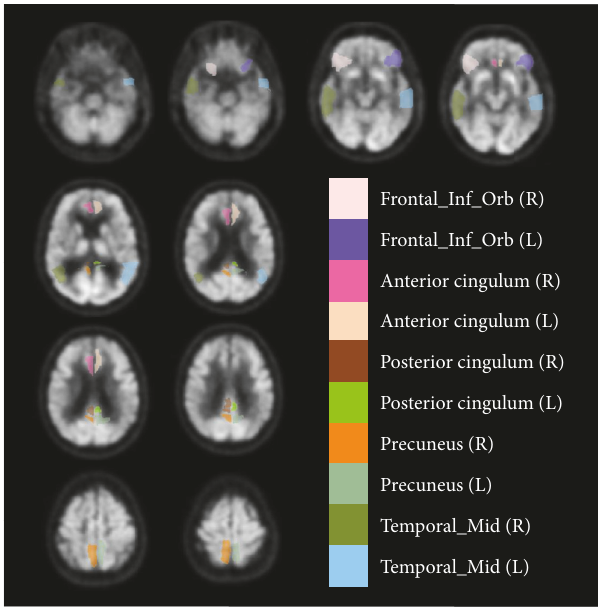
Figure 3: Selected regions of interest identified on PET images for cognitive classification tasks.